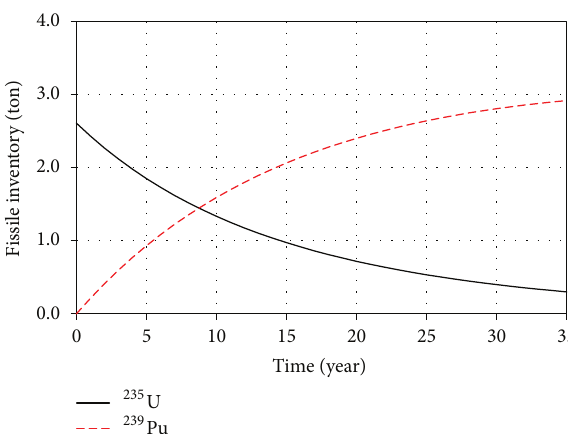
Figure 8: Fission rates of major nuclides.